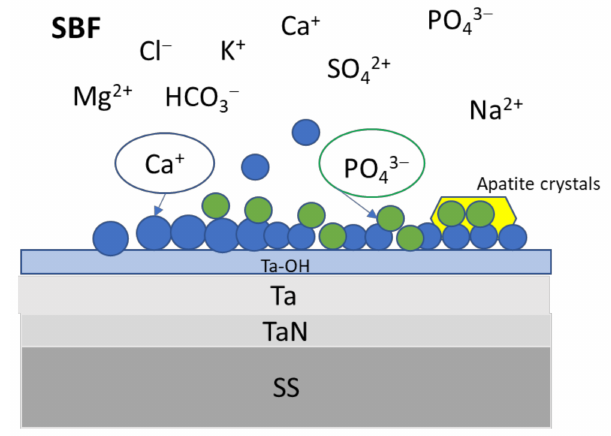
Figure 12. Scheme of HAp mechanism of formation.